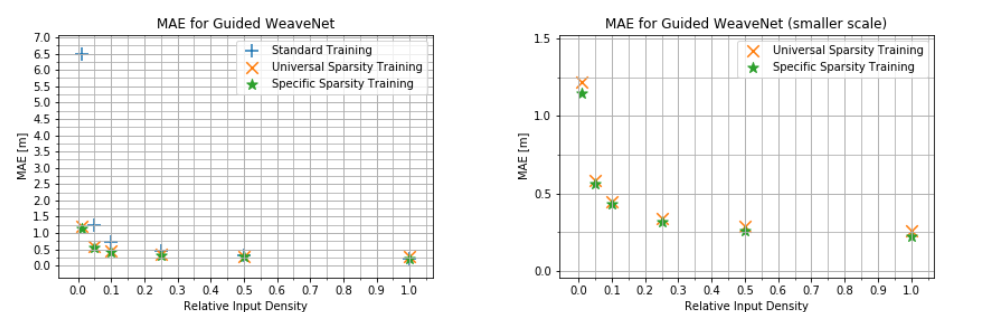
Figure 6. MAE for the guided WeaveNet for various input densities for different training modes (different scales).